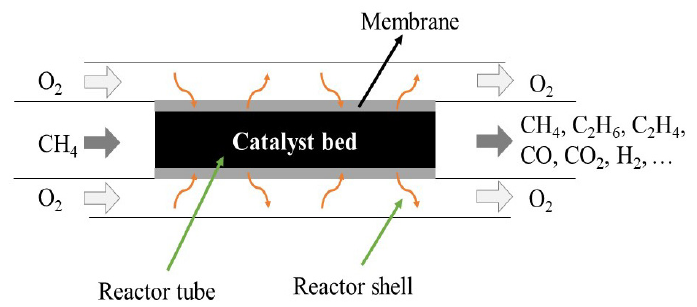
Figure 17. Membrane reactor configuration [133].